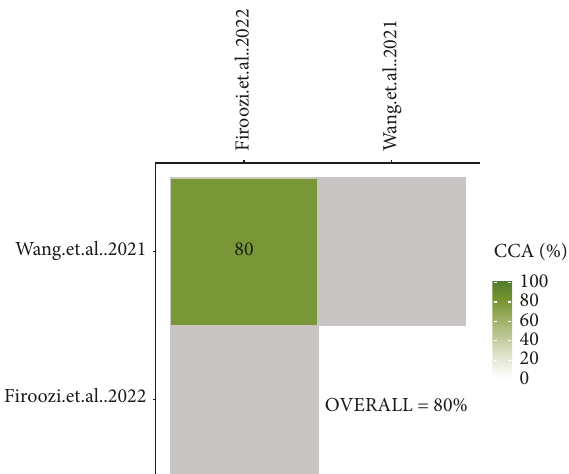
Figure 7: CCA grids of meta-analyses evaluating the effectiveness of Kinesio taping in reducing pain after third molar surgery.